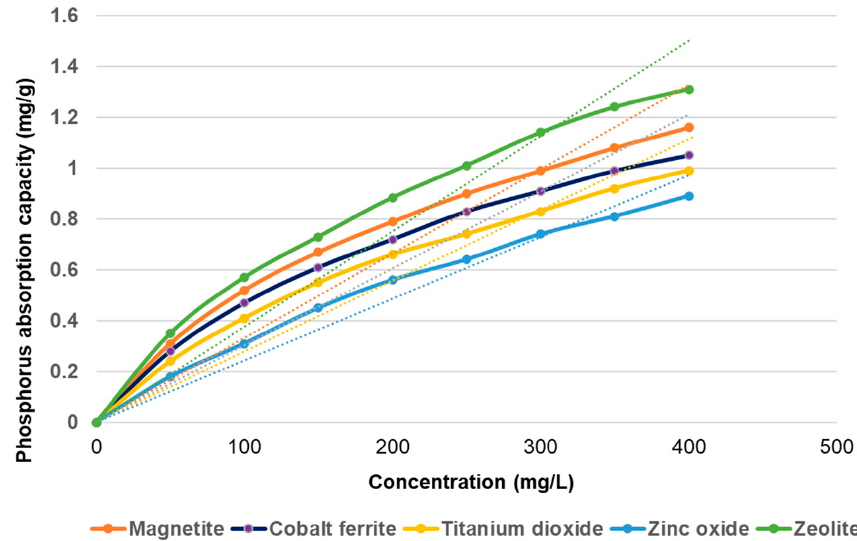
Figure 11. The adsorbents Langmuir and Freundlich isotherms.